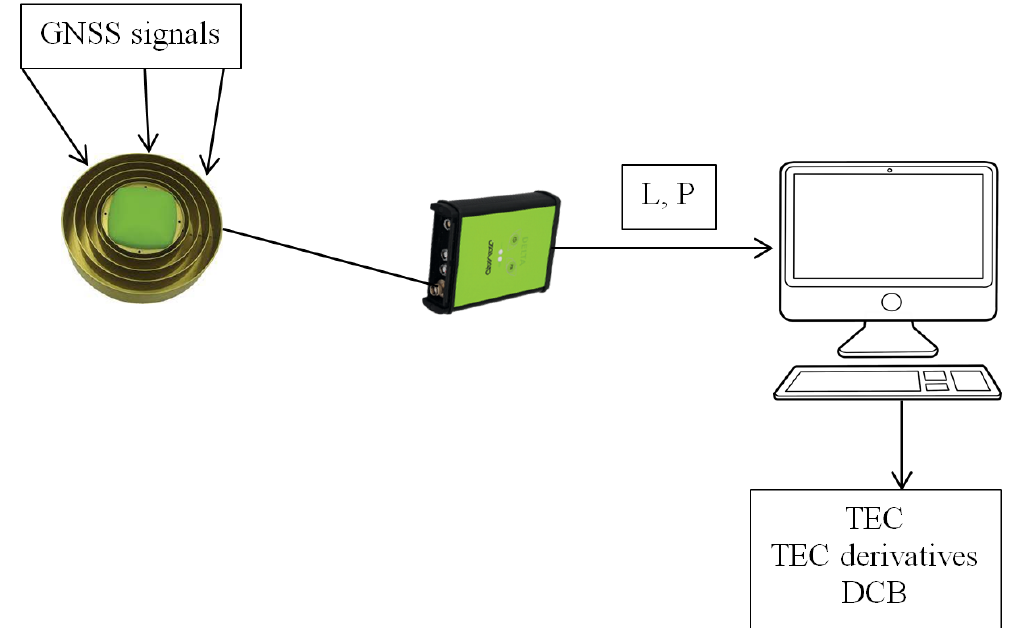
Figure 3. Hardware diagram for the suite to monitor the ionospheric TEC. L and P are phase and pseudo range data, correspondingly.